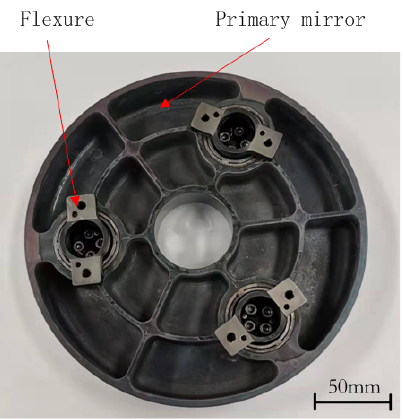
Figure 10. Prototype of the primary mirror assembly.